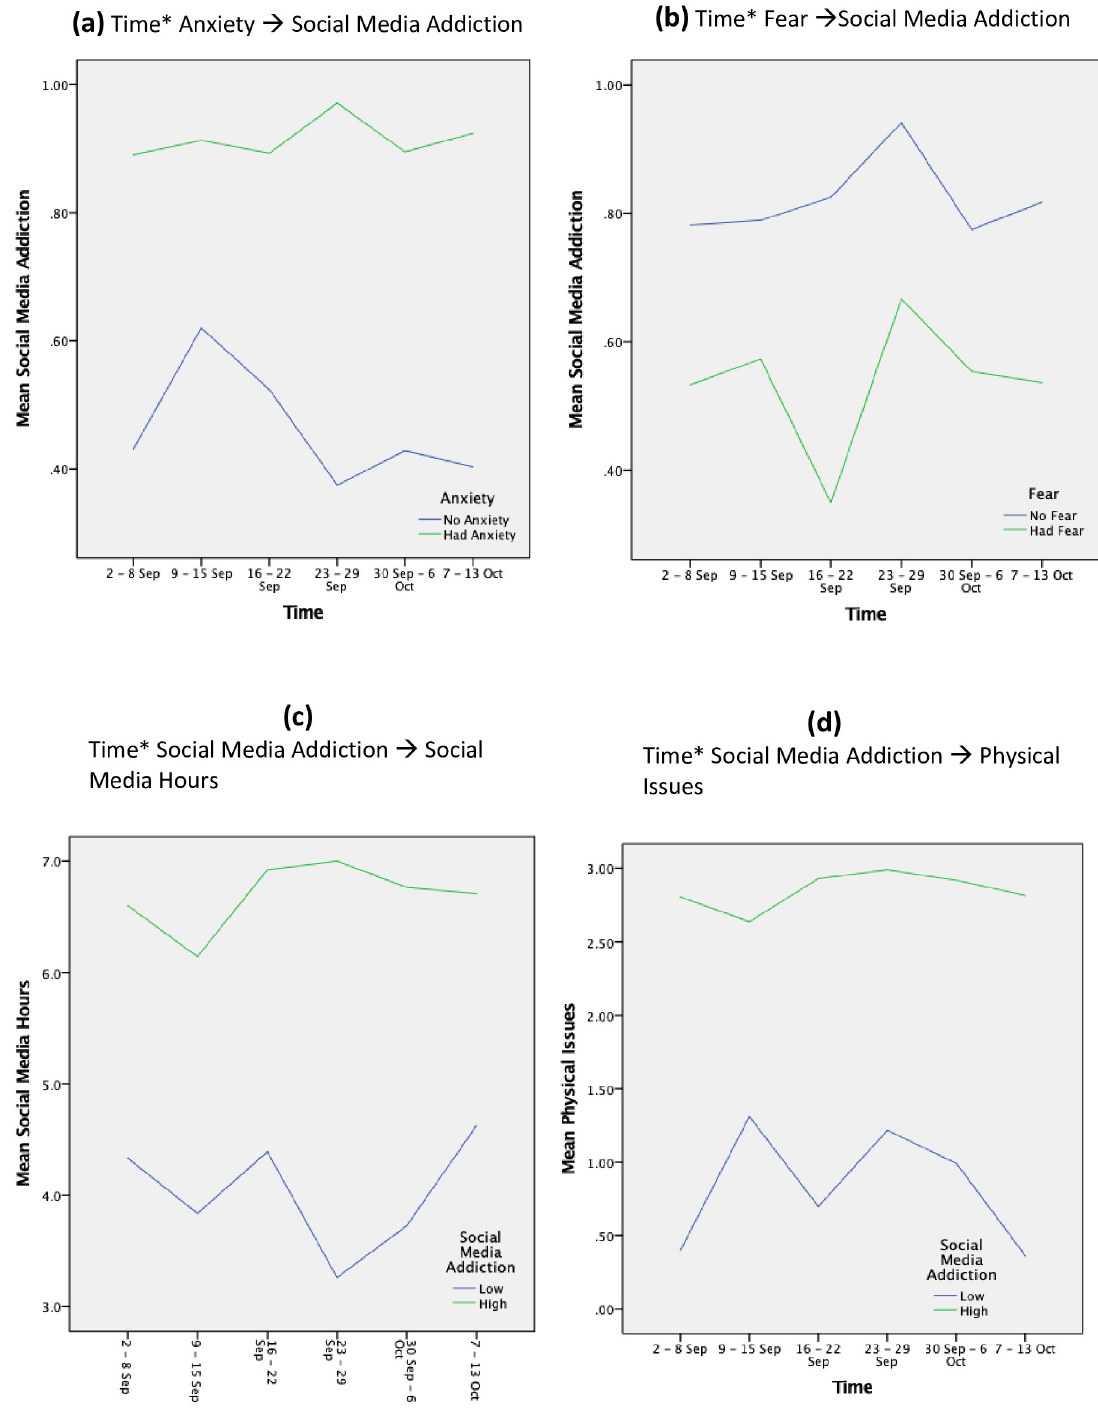
Fig 3. Interaction effects and the changes of the endogenous variables over time.